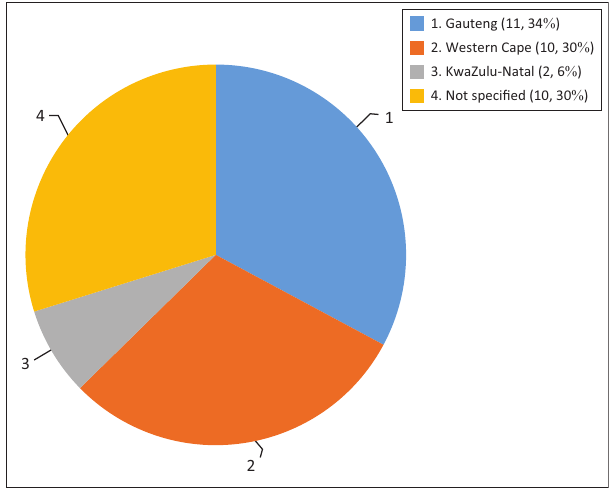
FIGURE 3: Geographical areas of